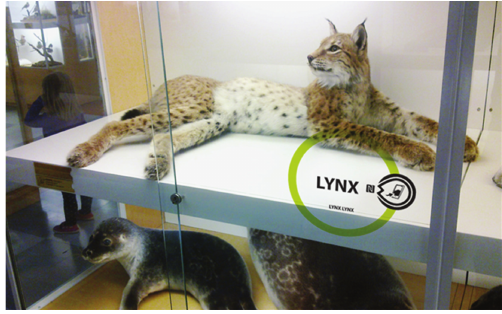
Figure 12: Collecting information in a museum: service advertisement next to an item.